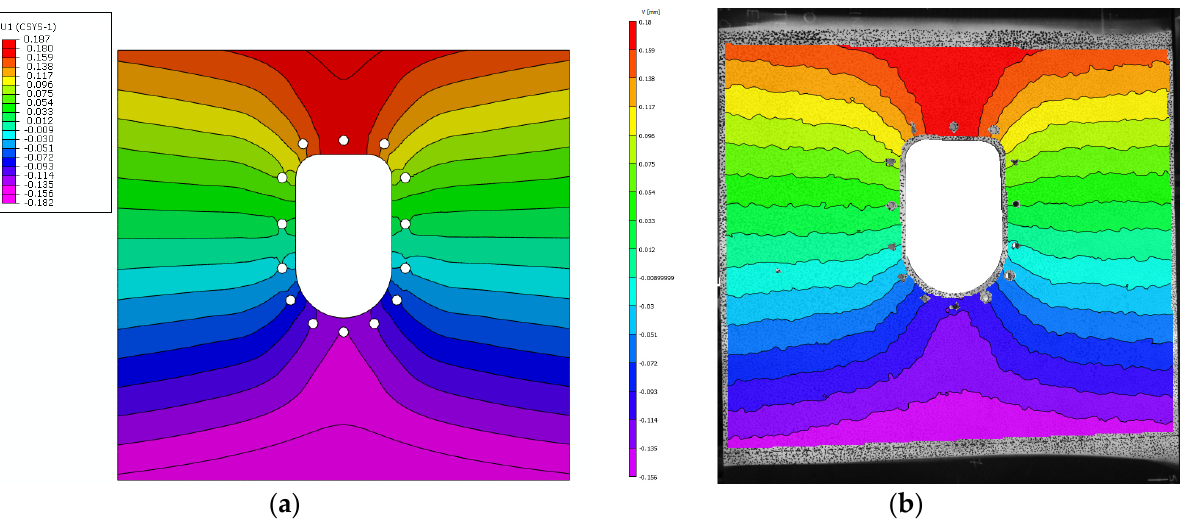
Figure 24. ( a ) Displacement contour in the loading direction according to FE analysis and ( b ) dis- placement contour in the loading direction according to DIC.